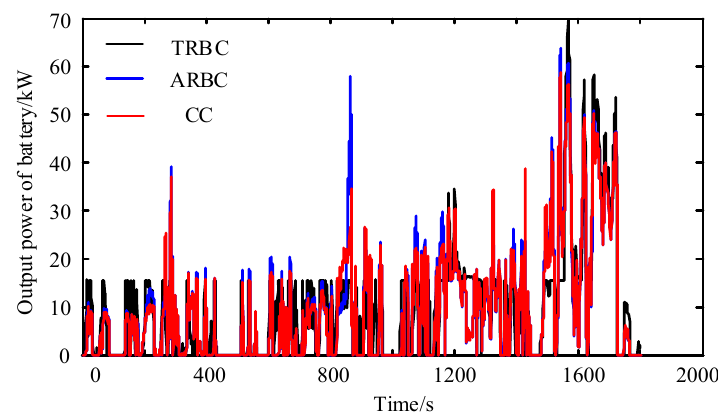
Figure 11. State of change (SOC) of the ultra ‐ capacitor.